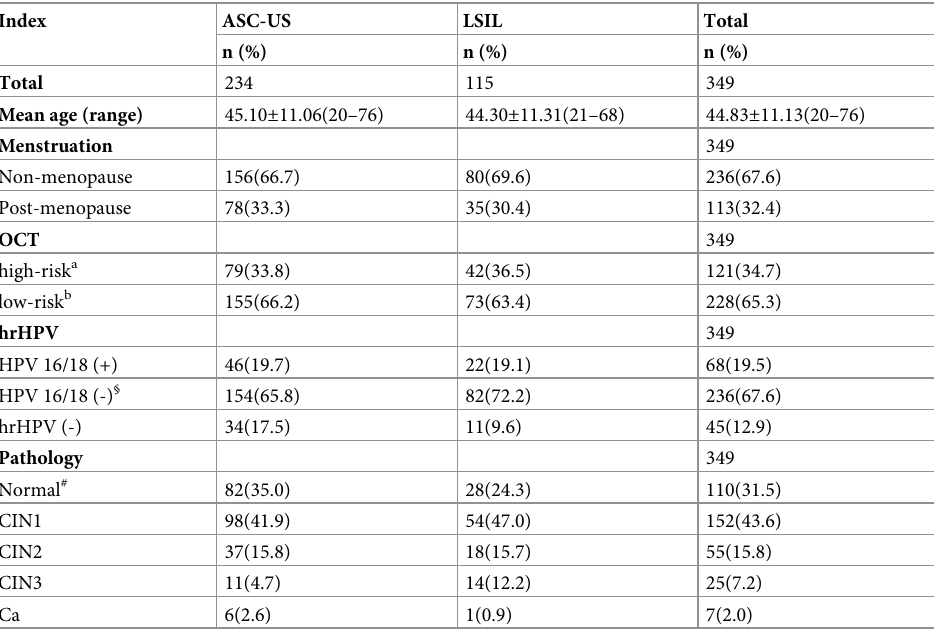
Table 1. Participants’ characteristics and clinical